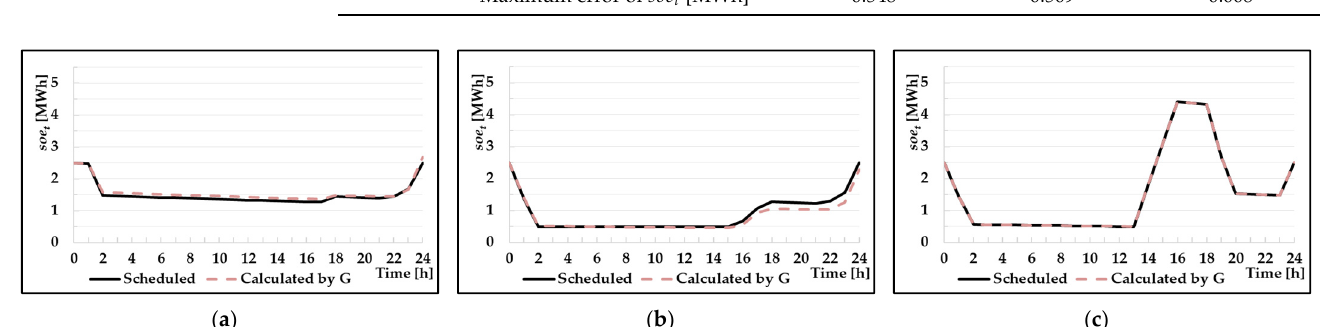
Figure 6. Variations of